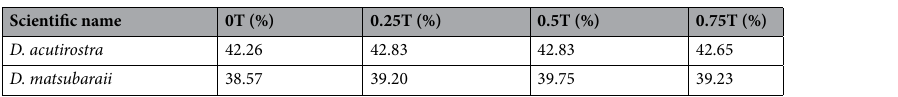
Table 1. Relationship between phase difference between left and right pectoral fin movements and propulsive efficiency ( T is the period).